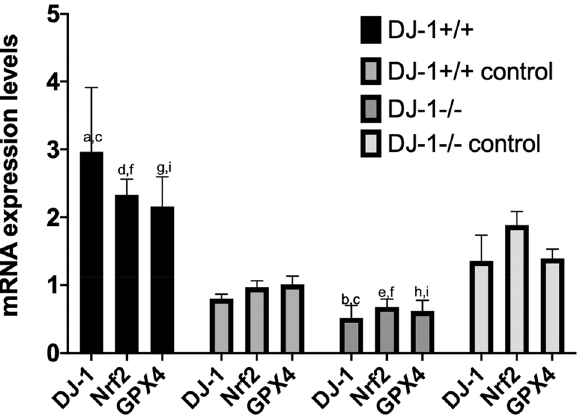
Figure 8. DJ‑1 and Nrf2/GPX4 signal pathway mRNA expression levels in transfected BeWo cells. ( a ) Compared to the DJ‑1 + / + negative control group, the expression level of DJ‑1 mRNA in BeWo cells from the DJ‑1 + / + group was significantly higher (P < 0.001). ( b ) Compared to the DJ‑1 −/− negative control group, the expression level of DJ‑1 mRNA in BeWo cells from the DJ‑1 −/− group was significantly lower (P = 0.042). ( c ) Compared to the DJ‑1 −/− group, the expression level of DJ‑1 mRNA in BeWo cells from the DJ‑1 + / + group was significantly higher (P < 0.001). ( d ) Compared to the DJ‑1 + / + negative control group, the expression level of Nrf2 mRNA in BeWo cells from the DJ‑1 + / + group was significantly higher (P < 0.001). ( e ) Compared to the DJ‑1 −/− negative control group, the expression level of Nrf2 mRNA in BeWo cells from the DJ‑1 −/− group was significantly lower (P < 0.001). ( f ) Compared to the DJ‑1 −/− group, the expression level of Nrf2 mRNA in BeWo cells from the DJ‑1 + / + group was significantly higher (P < 0.001). ( g ) Compared to the DJ‑1 + / + negative control group, the expression level of GPX4 mRNA in BeWo cells from the DJ‑1 + / + group was significantly higher (P < 0.001). ( h ) Compared to the DJ‑1 −/− negative control group, the expression level of GPX4 mRNA in BeWo cells from the DJ‑1 −/− group was significantly lower (P = 0.005). ( i ) Compared to the DJ‑1 −/− group, the expression level of GPX4 mRNA in BeWo cells from the DJ‑1 + / + group was significantly higher (P < 0.001). Differences among groups were compared by single factor analysis of variance (ANOVA) the type of post hoc test used LSD. (Biological replicates number: 2).